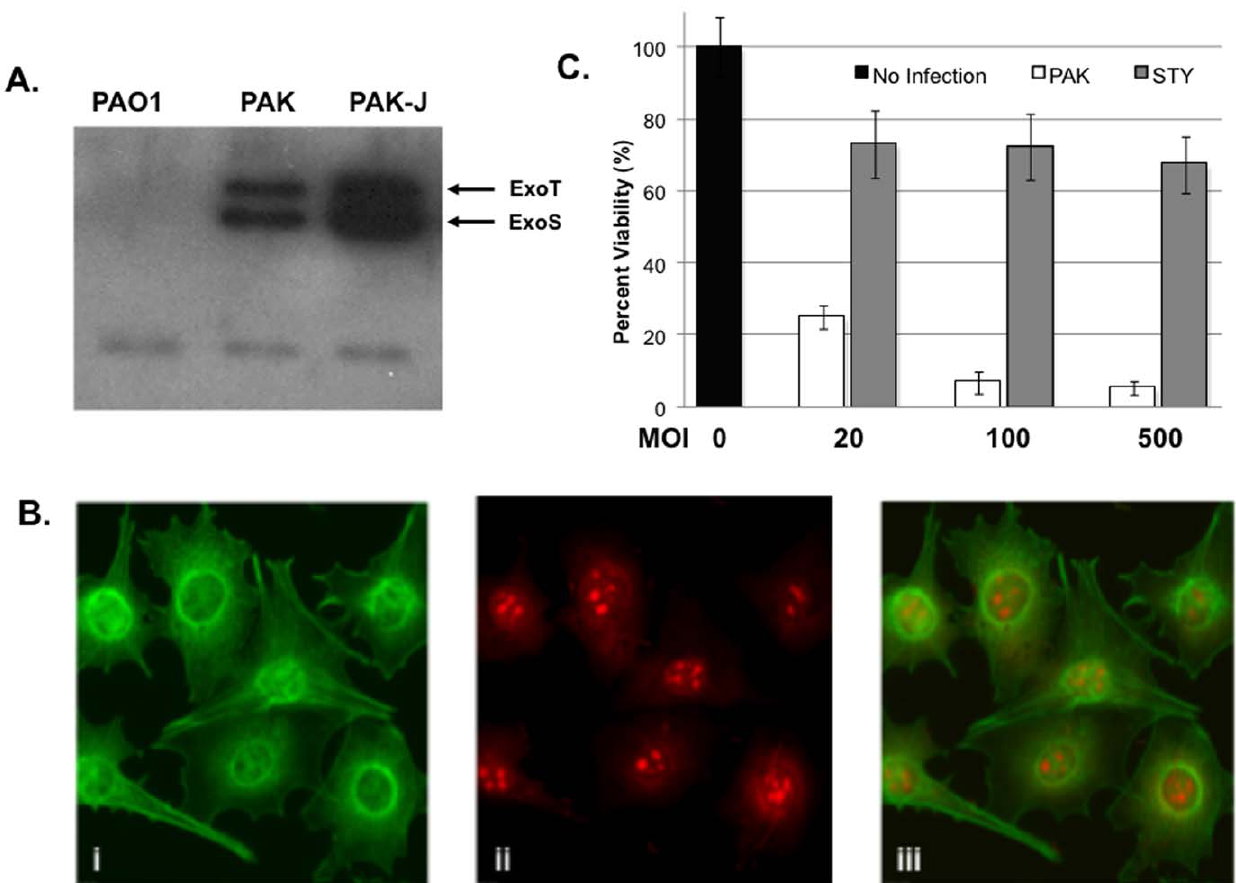
Figure 1. Protein delivery by type III secretion system of P.aeruginosa . ( A ) Comparison of ExoS secretion by standard laboratory strains of PAO1, PAK and a hyper secreting strain PAK-J. Strains were grown under type III secretion inducing conditions and culture supernatants were subjected to Western blot analysis using anti-ExoS antibody which recognizes both ExoS and ExoT. ( B ) Immunohistochemistry of MEF cells following infection by PAK-J (60 min at MOI 20). Cells were stained with anti-ExoS antibody followed by FITC labeled secondary antibody; (i) visualization of ExoS; (ii) visualization of nuclei with Propidium Iodine stain; (iii) compilation of (i) & (ii). ( C ) Comparison of MEF viability after 3 hour infection with PAK-J or PAK-J D STY at indicated